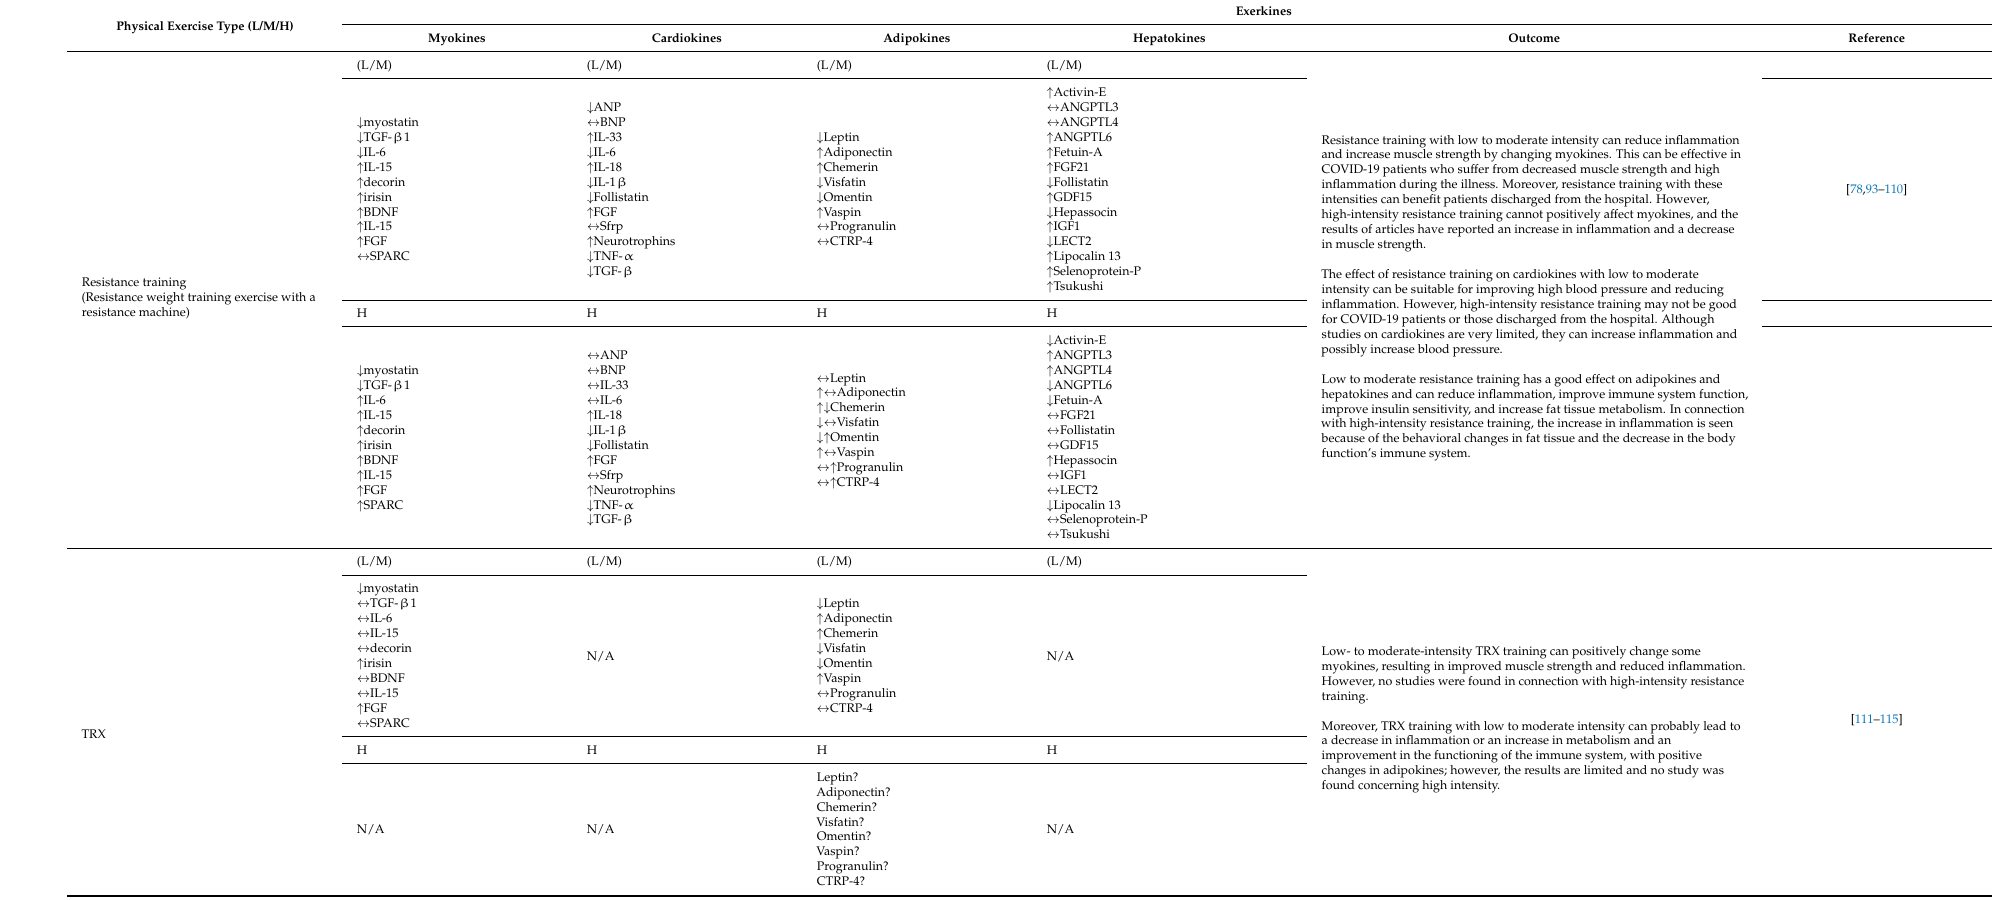
Table 1. The effect of different types and intensities of physical exercise (low, moderate, and high) on the stimulation of